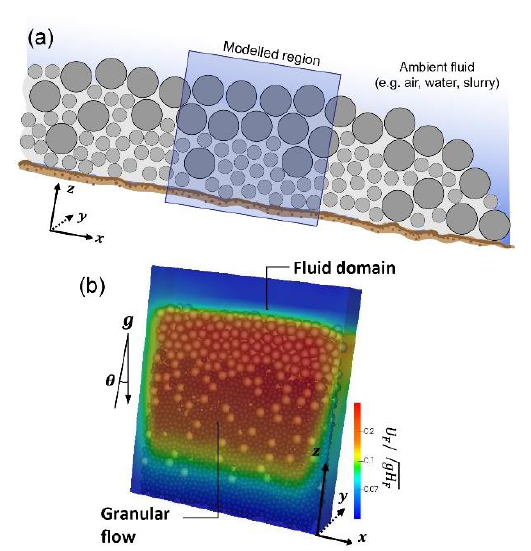
Fig. 1 . (a) A schematic diagram of the modelled system and (b) illustration of an actual simulated case which is similar to the encased region in